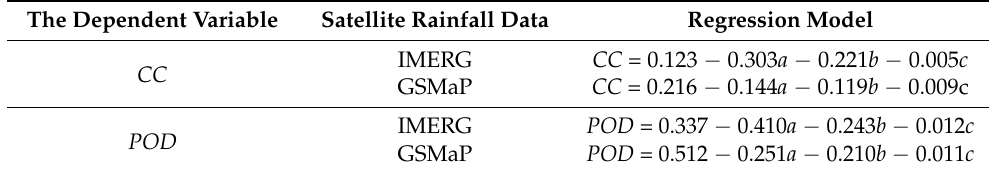
Figure 5. Multiple regression analysis of IMERG and GSMaP products. Table 6. Multiple regression analysis results. The newly constructed principal components a, b, c are independent variables, and the accuracy evaluation metrics CC and POD are taken as the dependent